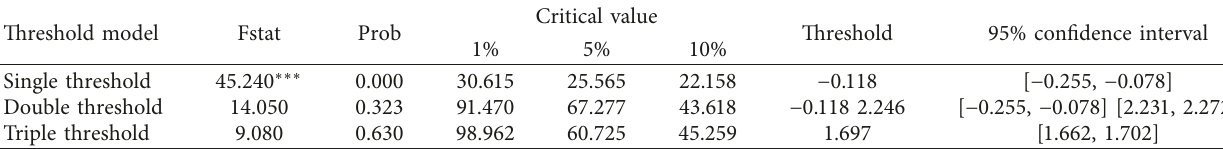
Table 6: Threshold effect significance results of capital intensity.